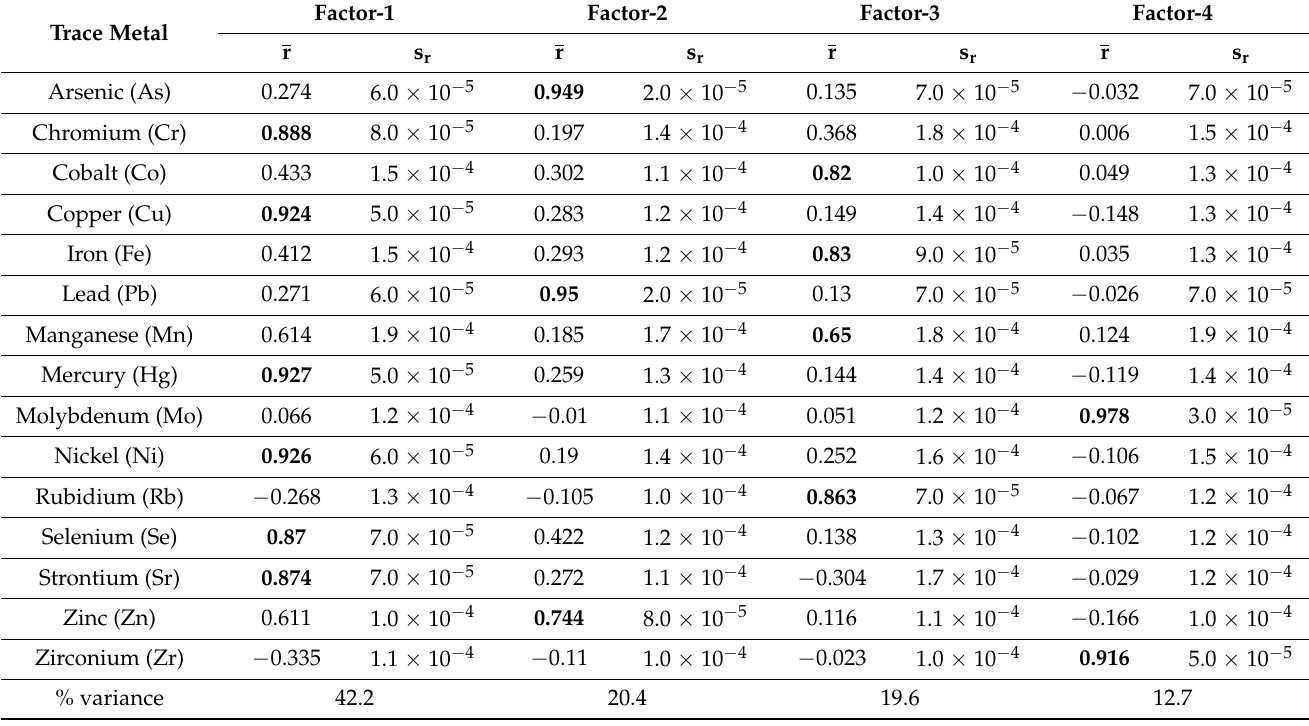
Table 9. Syracuse trace metal induced uniform distributed measurement error varimax-rotated factor dimensions: census tract averaged soil sample data (10,000